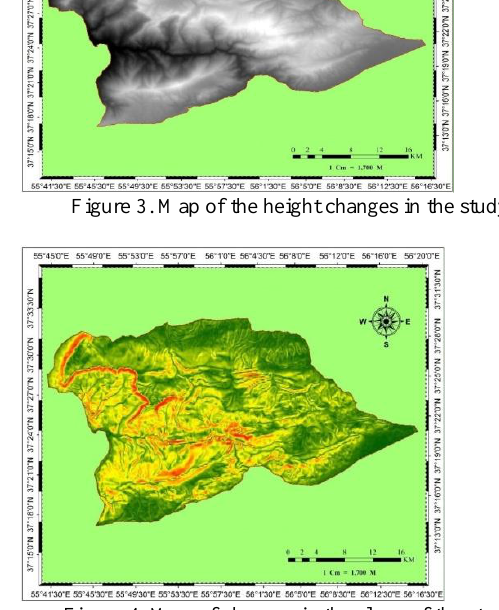
Figure 4. Map of changes in the slope of the study area